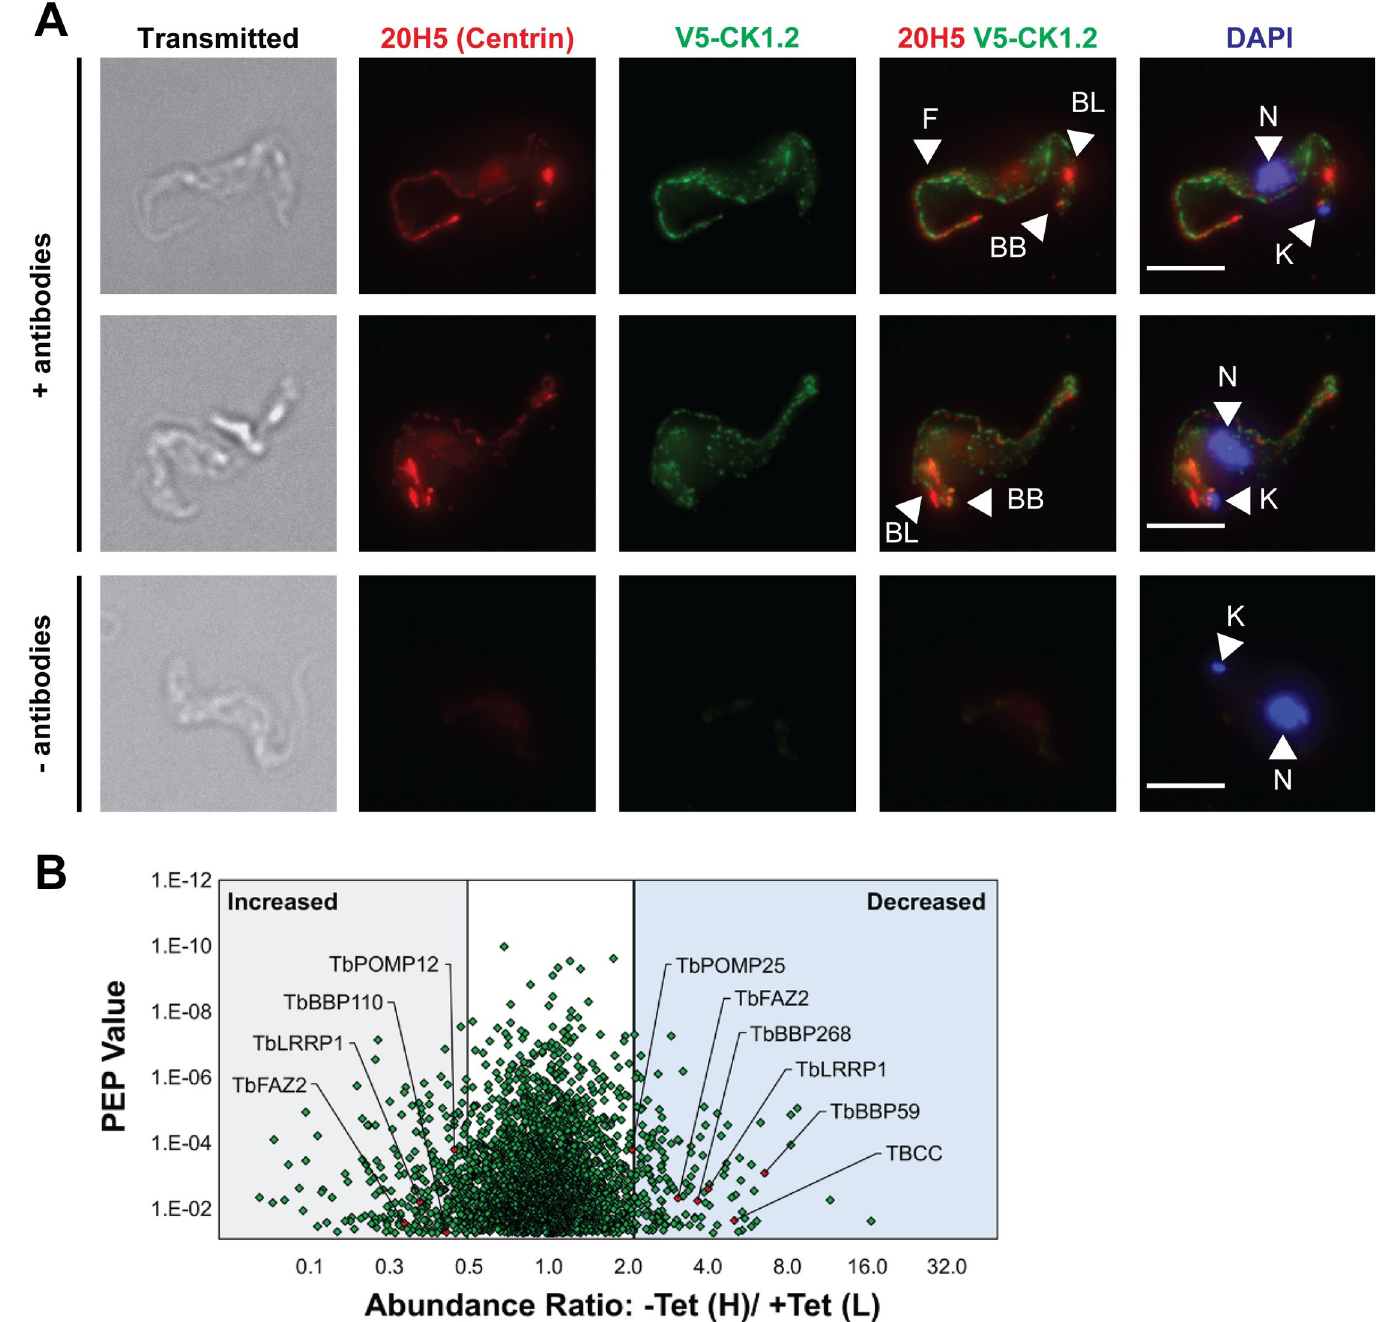
Fig 6. Intracellular location of TbCK1.2: Identification of candidate TbCK1.2-pathway proteins. ( A ) Trypanosomes expressing TbCK1.2 tagged at its N-terminus with V5 epitope were fixed with methanol and probed with anti-V5 antibody. Anti-centrin antibody 20H5 was used to stain basal bodies and bilobes, and DAPI was used to stain DNA. Control images show a V5-TbCK1.2 tagged line without addition of primary antibodies. Arrowheads indicate flagellum (F), basal bodies (BB), bilobes (BL), nuclei, (N), and kinetoplasts (K). Scale bar = 5 µ m. ( B ) Following knockdown (24 h) of TbCK1.2, SILAC phosphoproteomics was used to identify candidate TbCK1.2-pathway proteins. The abundance ratio (H/L) of identified phosphopeptides is plotted as a function of their posterior error probability (PEP) value. Only peptides with a PEP score of 5 x 10 − 2 (5% chance of error), or lower, are presented. Grey area represents phosphopeptides with a 2-fold or greater increase in abundance. Blue shading indicates phosphopeptides that decreased in abundance 2-fold or greater.